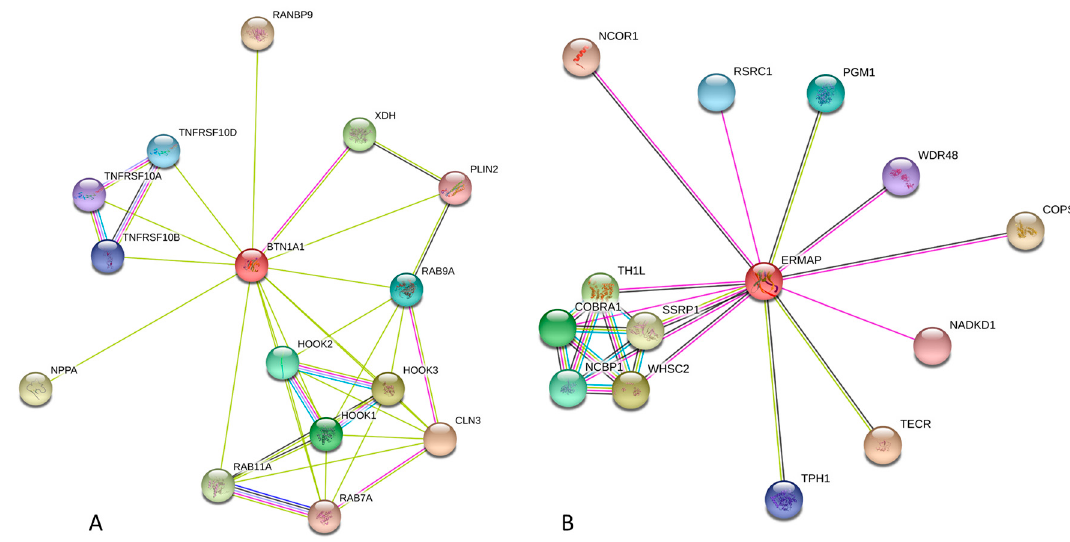
Figure 6. Evaluation of the interactivity of some human butyrophilins. Human BT1NA1 ( A ) and ERMAP ( B ) were analyzed by STRING platform (http://string-db.org/cgi/) [63]. An edge, which represents protein-protein interaction, may be drawn with up to 7 differently colored lines that reflect the existence of seven types of evidence used in predicting the associations. A red line indicates the presence of fusion evidence; a green line–neighborhood evidence; a blue line–co-occurrence evidence; a purple line–experimental evidence; a yellow line–text mining evidence; a light blue line–database evidence; a black line–co-expression evidence.